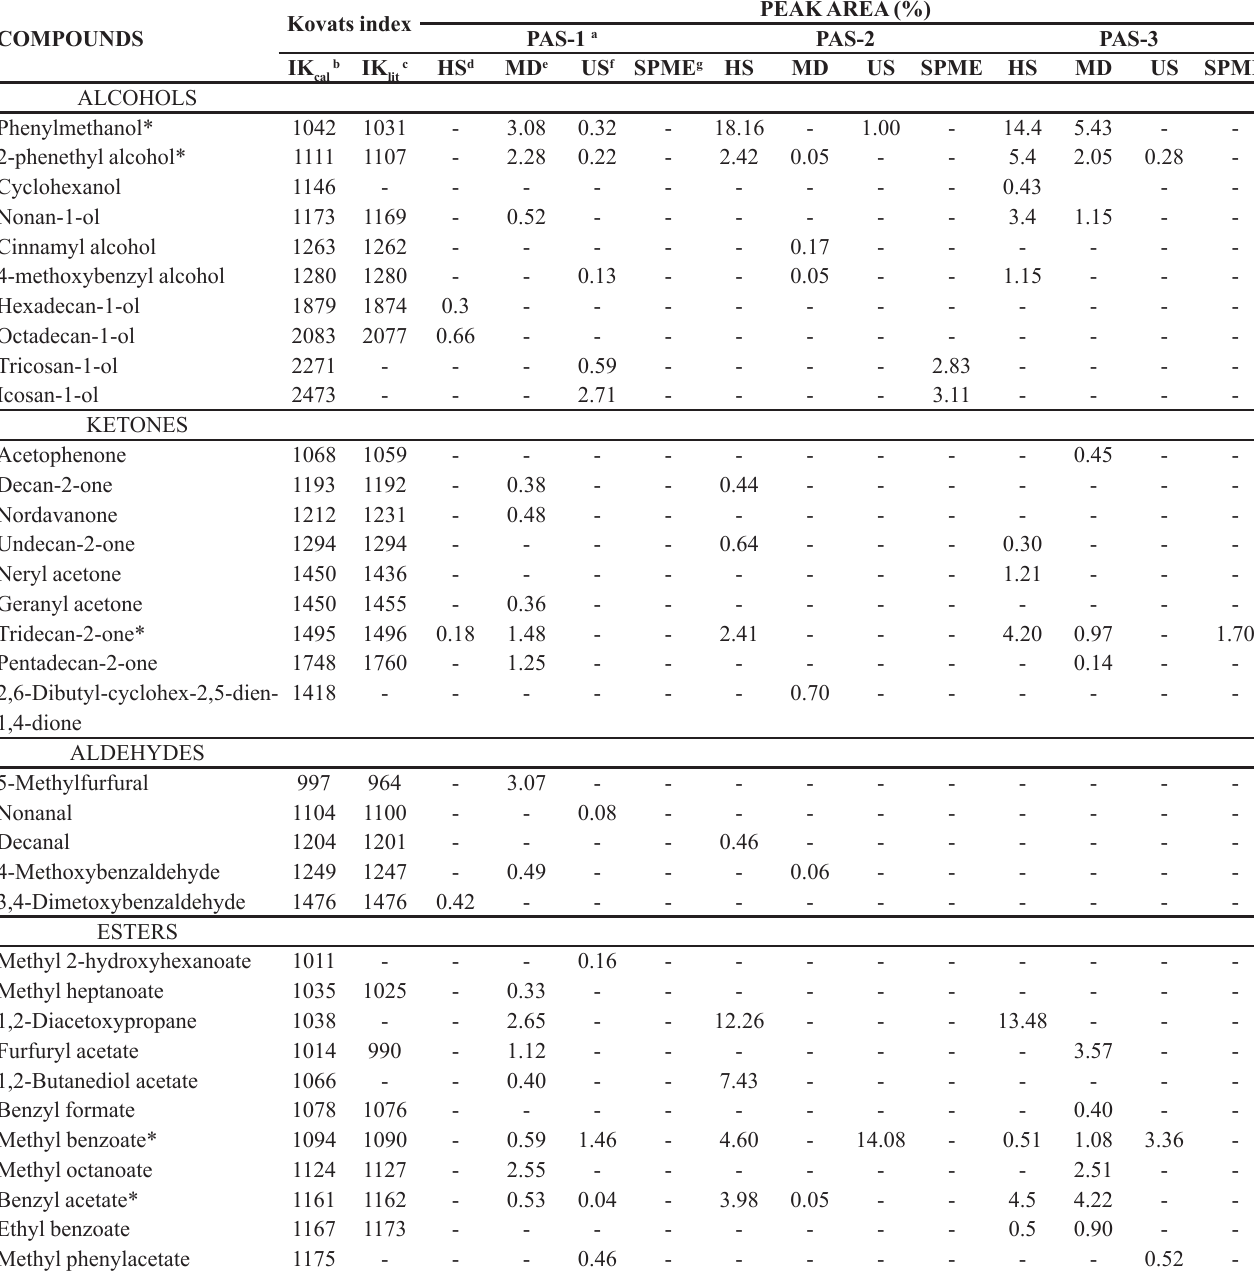
TABLE I - Chemical constituents of volatile stingless bee pollen collected in the months of December, March and July and extracted by HS, MD, US and SPME with their relative abundances Kovats index COMPOUNDS